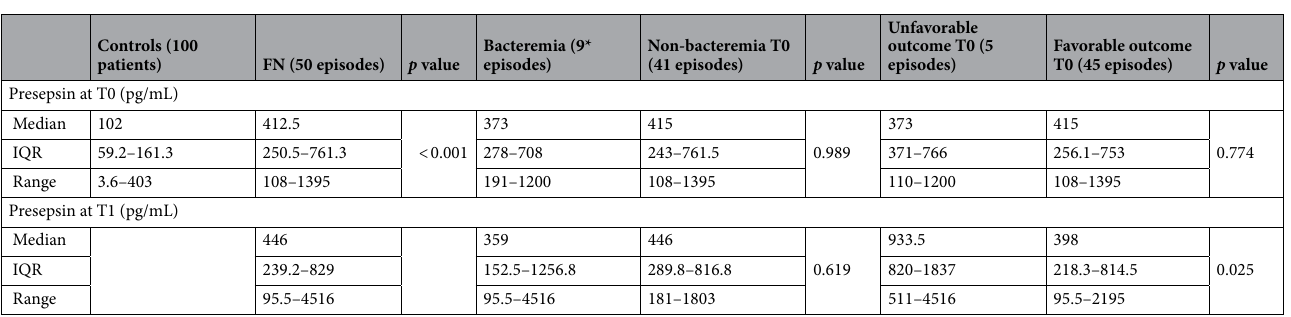
Table 2. Comparison of presepsin values between controls and patients and between patients with and without bacteremia and between patients favorable and unfavorable outcome. FN: febrile neutropenia; IQR: interquartile range. *Among the 9 bacteremias, 2 were caused by Gram + bacteria (1 S. mitis and 1 S. aureus + M. luteus) and 7 by Gram- (3 E. Coli, 3 E. cloacae, 1 P. aeruginosa, 1 P. aeruginosa + K. pneumoniae, 1 K.